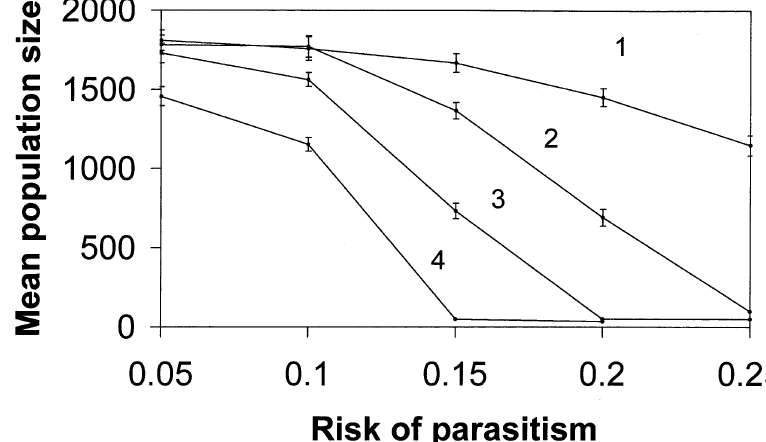
Fig. 2. Mean population size in over 100 simulations versus risks of para- sitism (probability that a brood cell will be parasitized). The scenarios differ with regard to the level of food availability which was de- scribed by the number of days need- ed for the provision of one daughter cell. 1: rich habitat (1 d), 2: medium